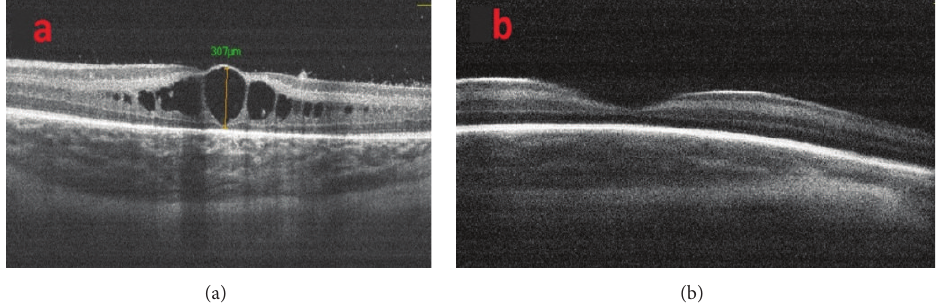
Figure 5: (a) OCT image of a premature infant with type 1 ROP (zone 2 stage 3 with plus disease) before intravitreal ranibizumab treatment and (b) two months after intravitreal ranibizumab